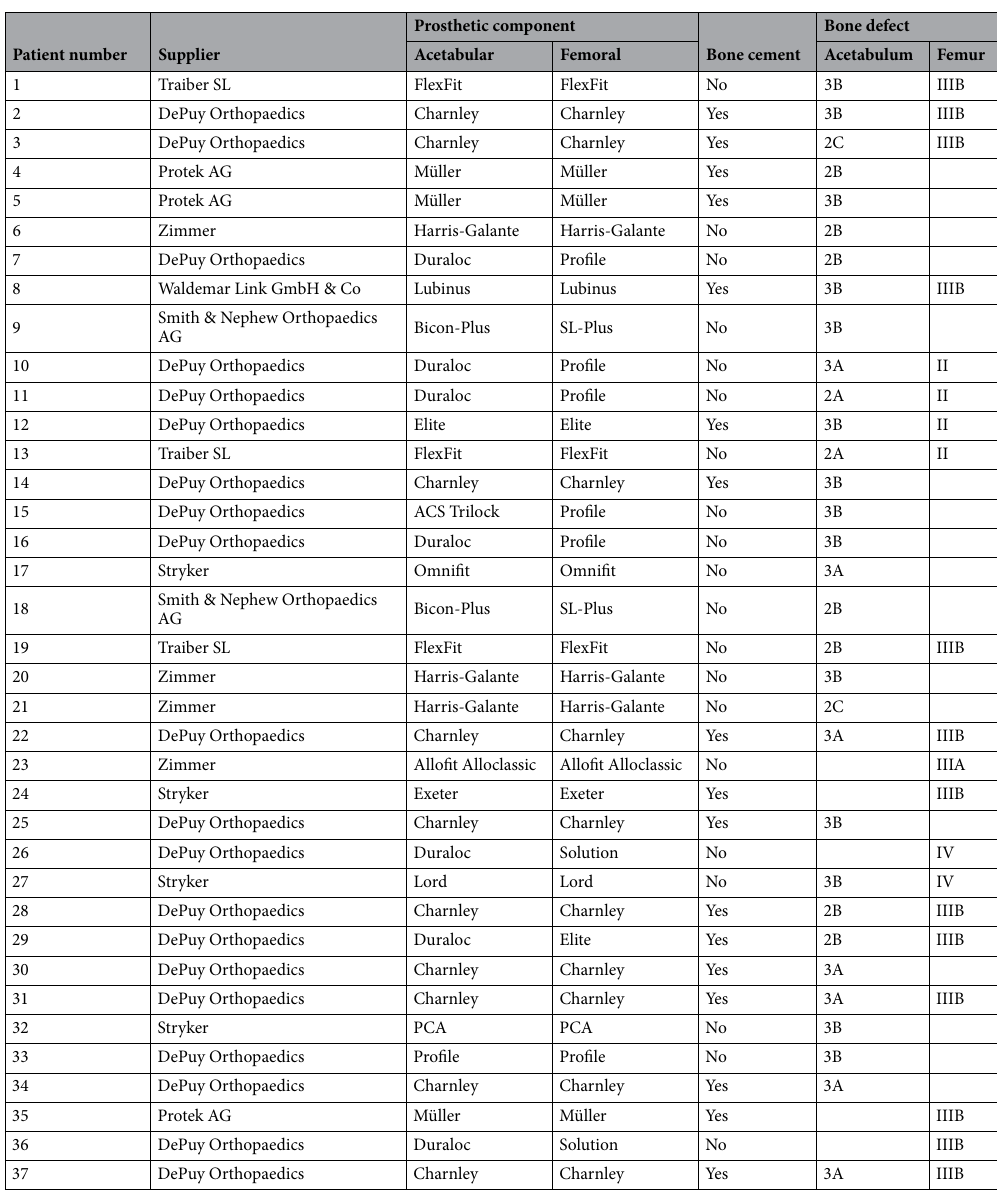
Table 2. Type of prostheses and bone defects in patients with aseptic loosening